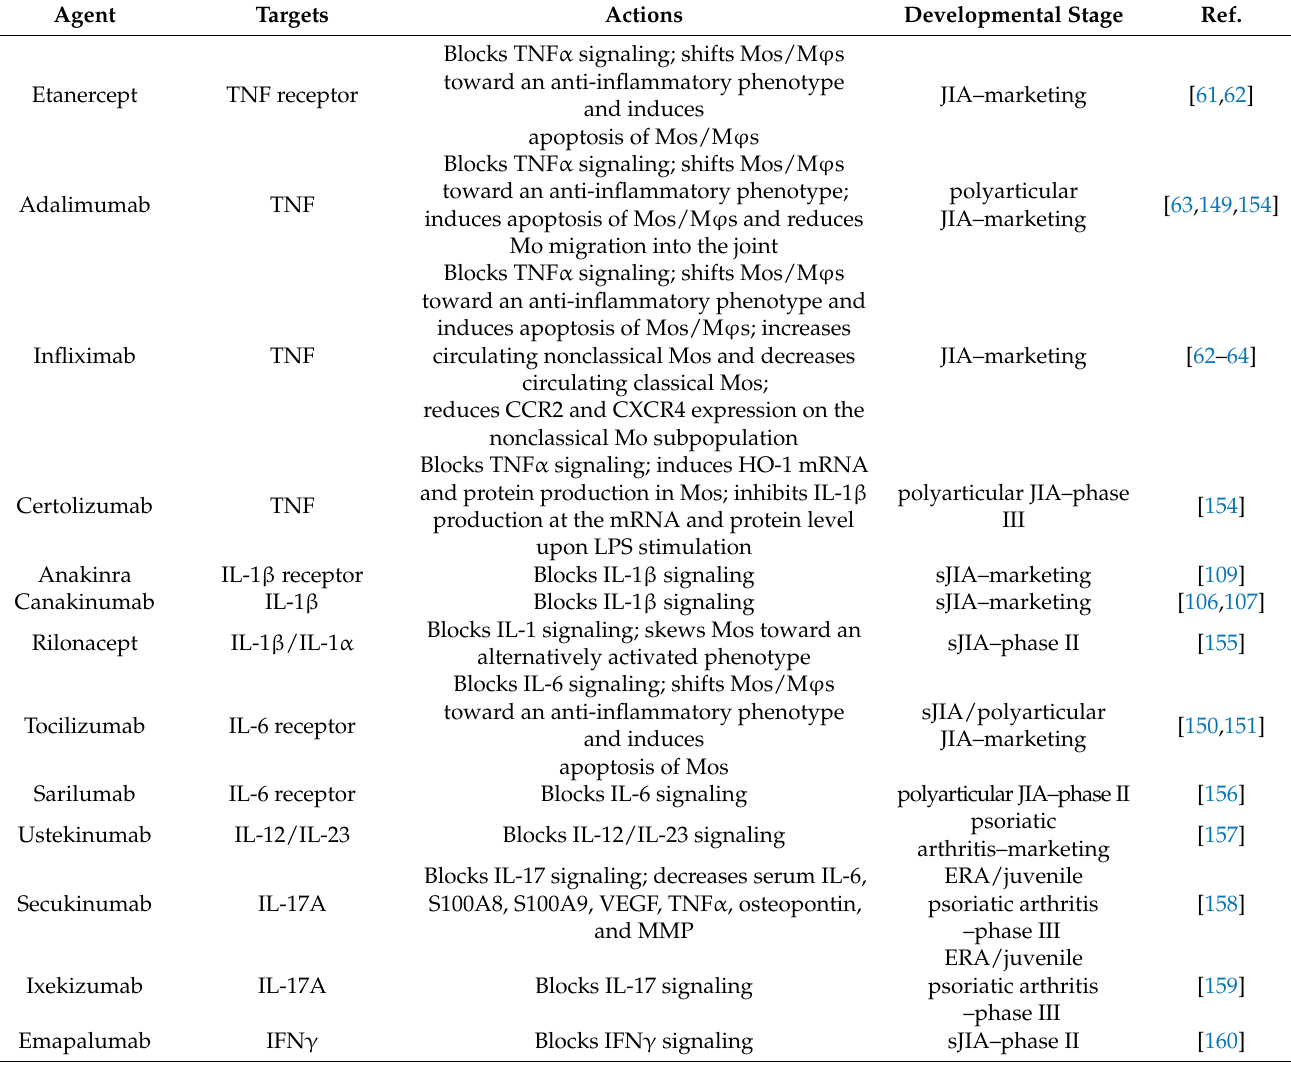
Table 2. Therapeutic agents targeting monocytes/macrophages and their functional activities.